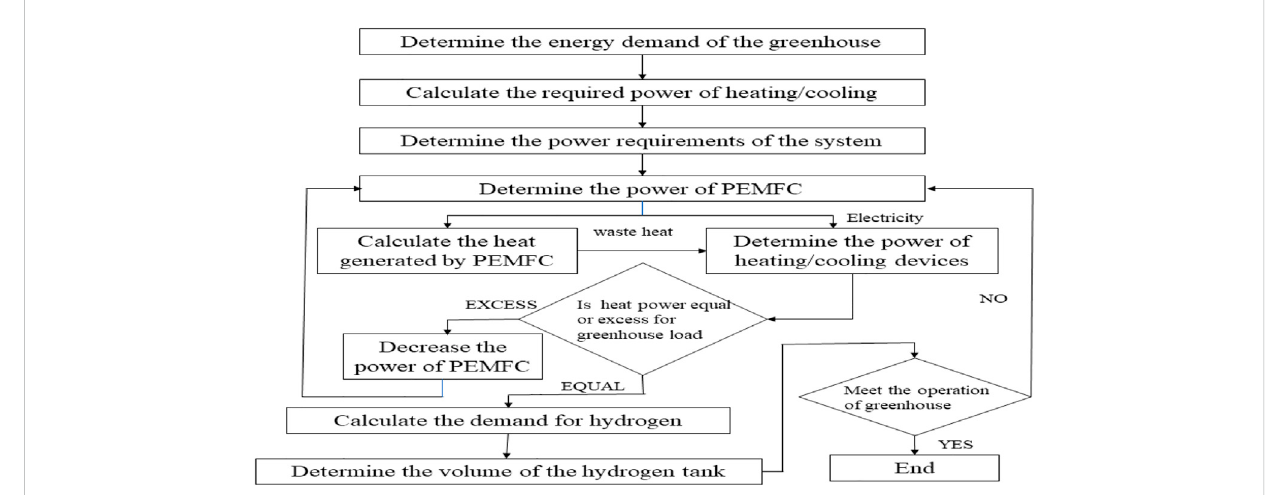
FIGURE 9 Working strategy of the hydrogen greenhouse triple cogeneration system.